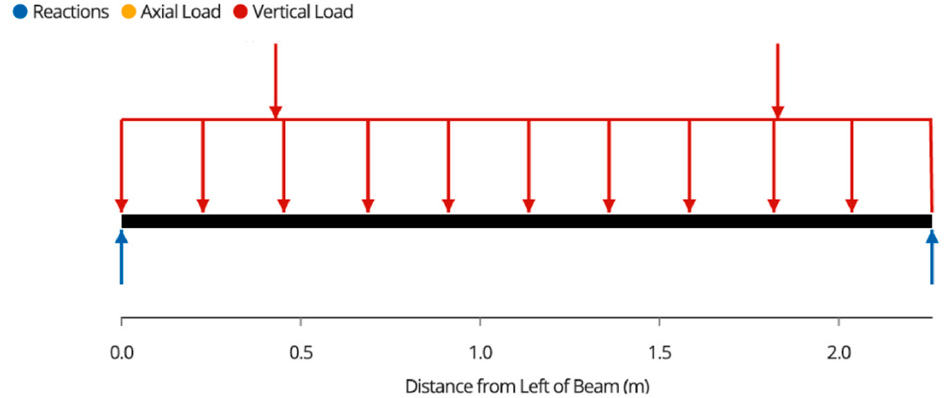
Figure A5. The 2 × 4 Weight Free Body Diagram. The shear force diagram is shown in Figure A6.